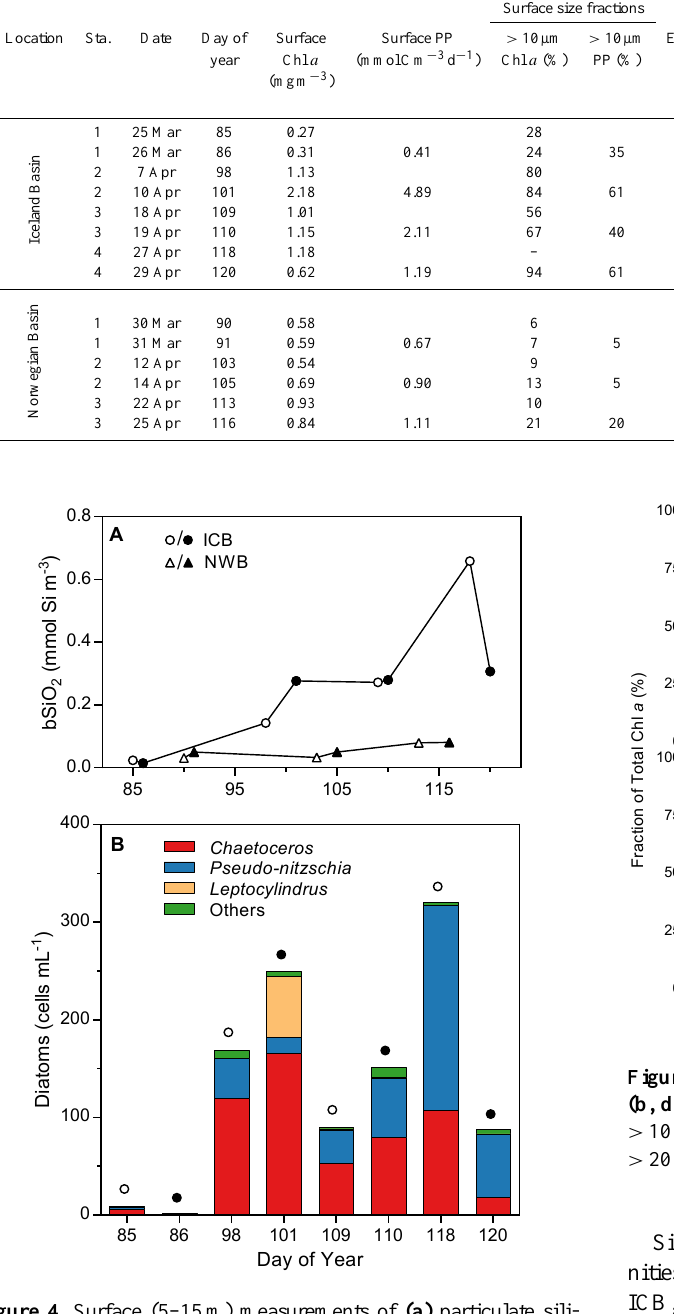
NWB, peak Chl a occurred during the late summer bloom (1.6 mg m − 3 , Fig. 3d).